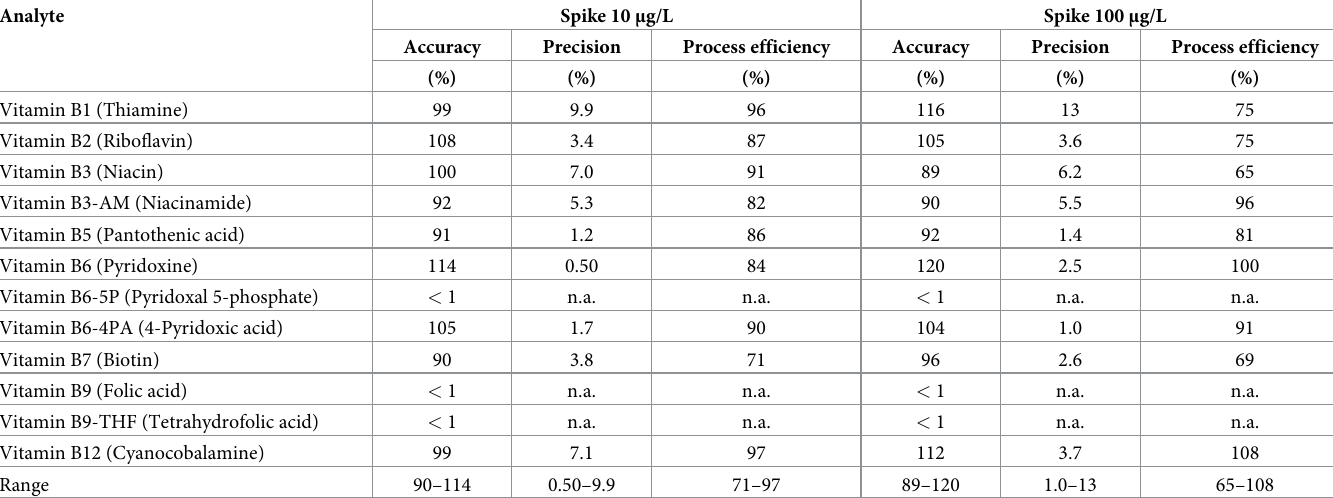
Table 4. Validation characteristics of the method using ZnSO 4 /methanol as a precipitating agent.